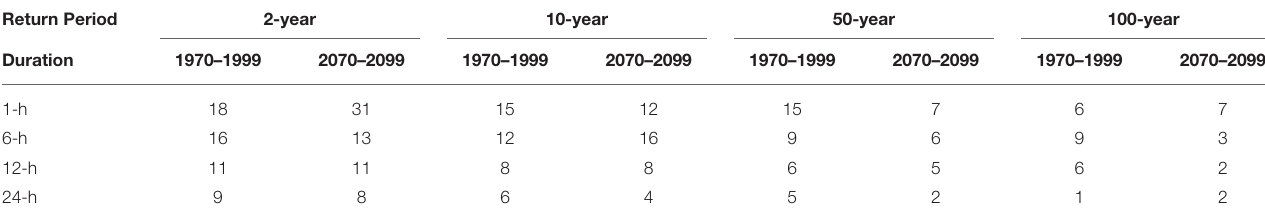
TABLE 4 | Percent decrease (%) in CSO total volume from the w/o PP to w/PP scenarios (w/o PP: without porous pavements; w/ PP: with porous pavements). Return Period